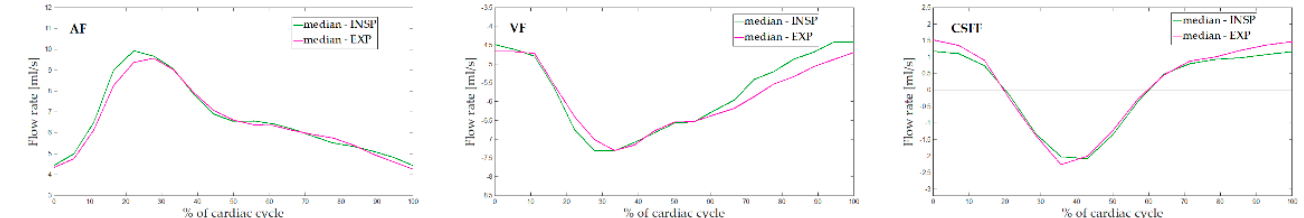
Figure 4. Example of inspiration (INSP, cyan) and expiration (EXP, magenta) median beats in AF, VF, and CSFF in one subject. The represented plots were computed from the MRI data of the same subject represented in Figure 1.